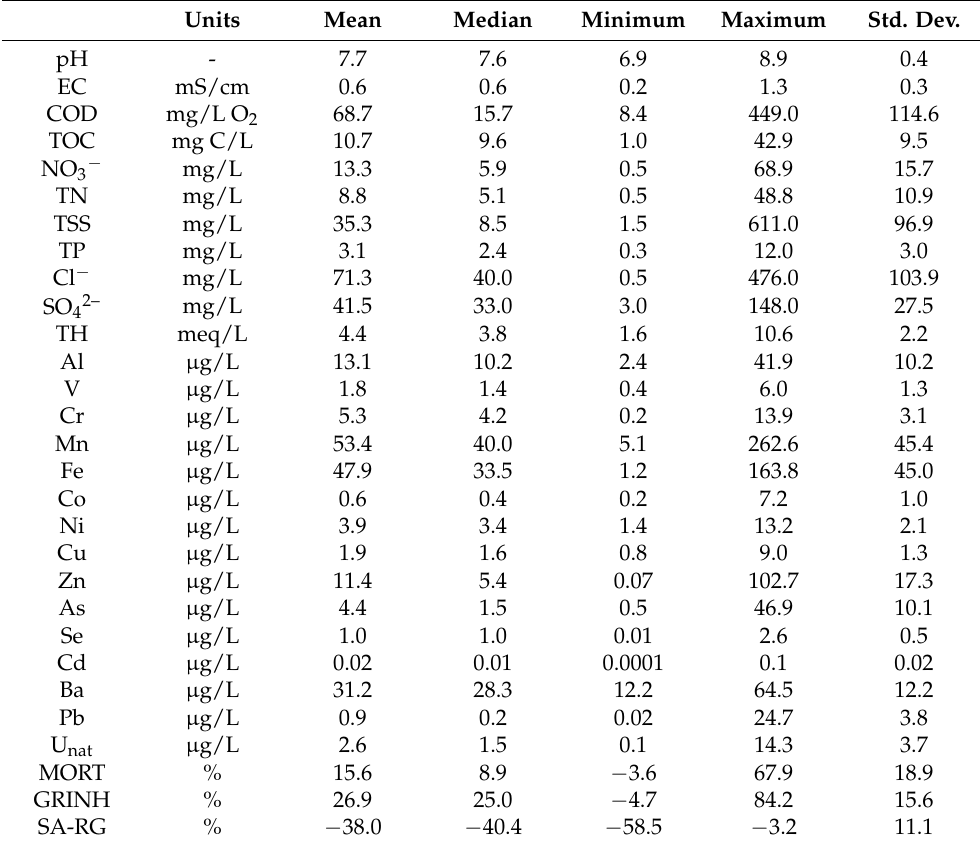
Table 2. Basic statistics of water quality parameters ( n = 44).